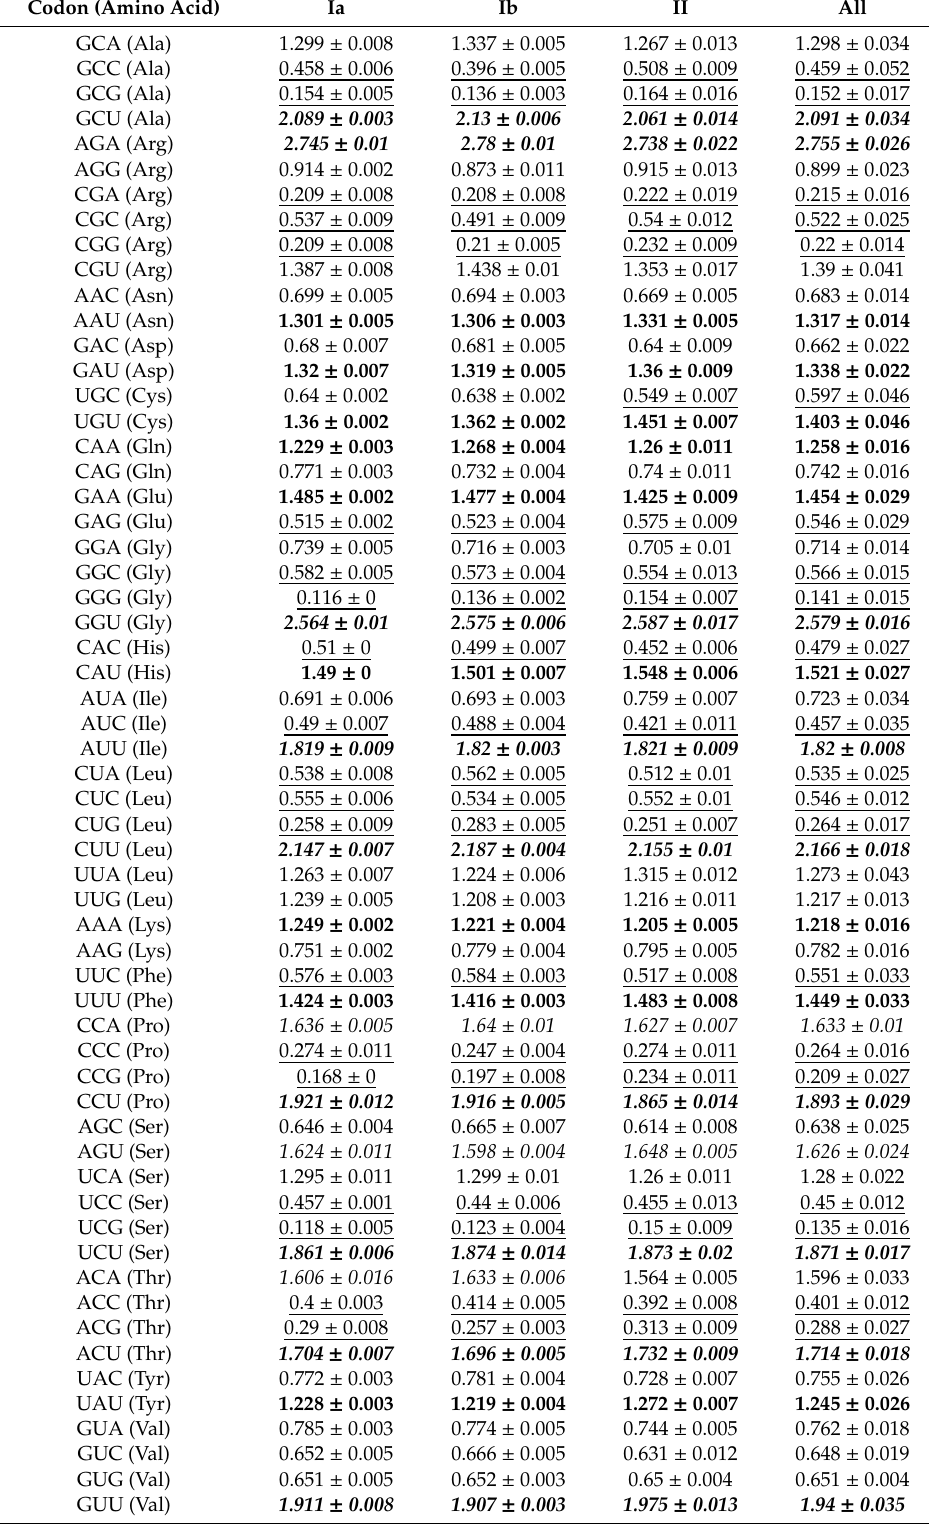
Table 2. Synonymous codon usage of the TGEV complete CDS. The RSCU values of 59 synonymous codons are presented. The preferred, over-represented (RSCU > 1.6), and under-represented (RSCU < 0.6) codons are displayed in bold, italics, and underscore, respectively. Codon (Amino